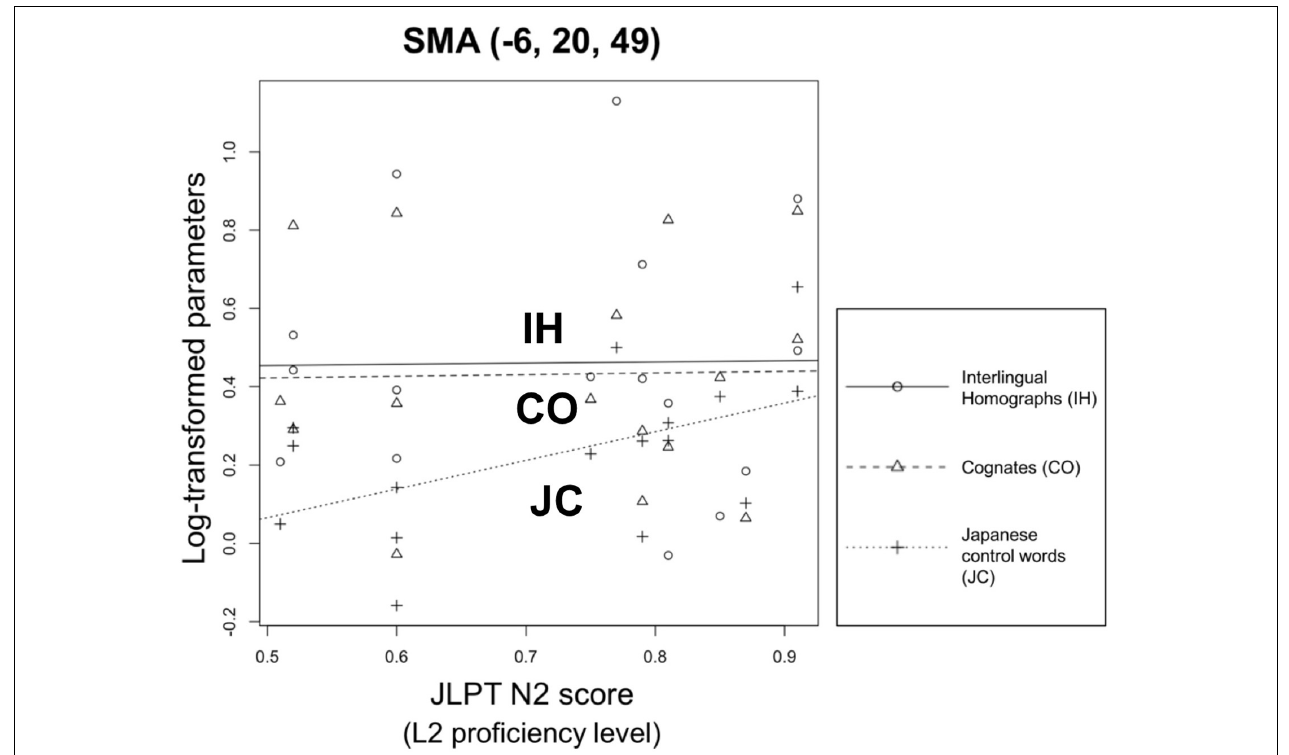
FIGURE 5 | Relationship between participants’ proficiency level and response to types of words in the SMA. The x -axis represents the bilinguals’ L2 proficiency level. The y -axis indicates the log-transformed response data of the SMA activity level. Even though significant difference could be observed from the types of words (IH, CO, and JC), the effect of L2 proficiency is inconsistent among three types of words [ F (1,44) = 0.88, p = 0.35].